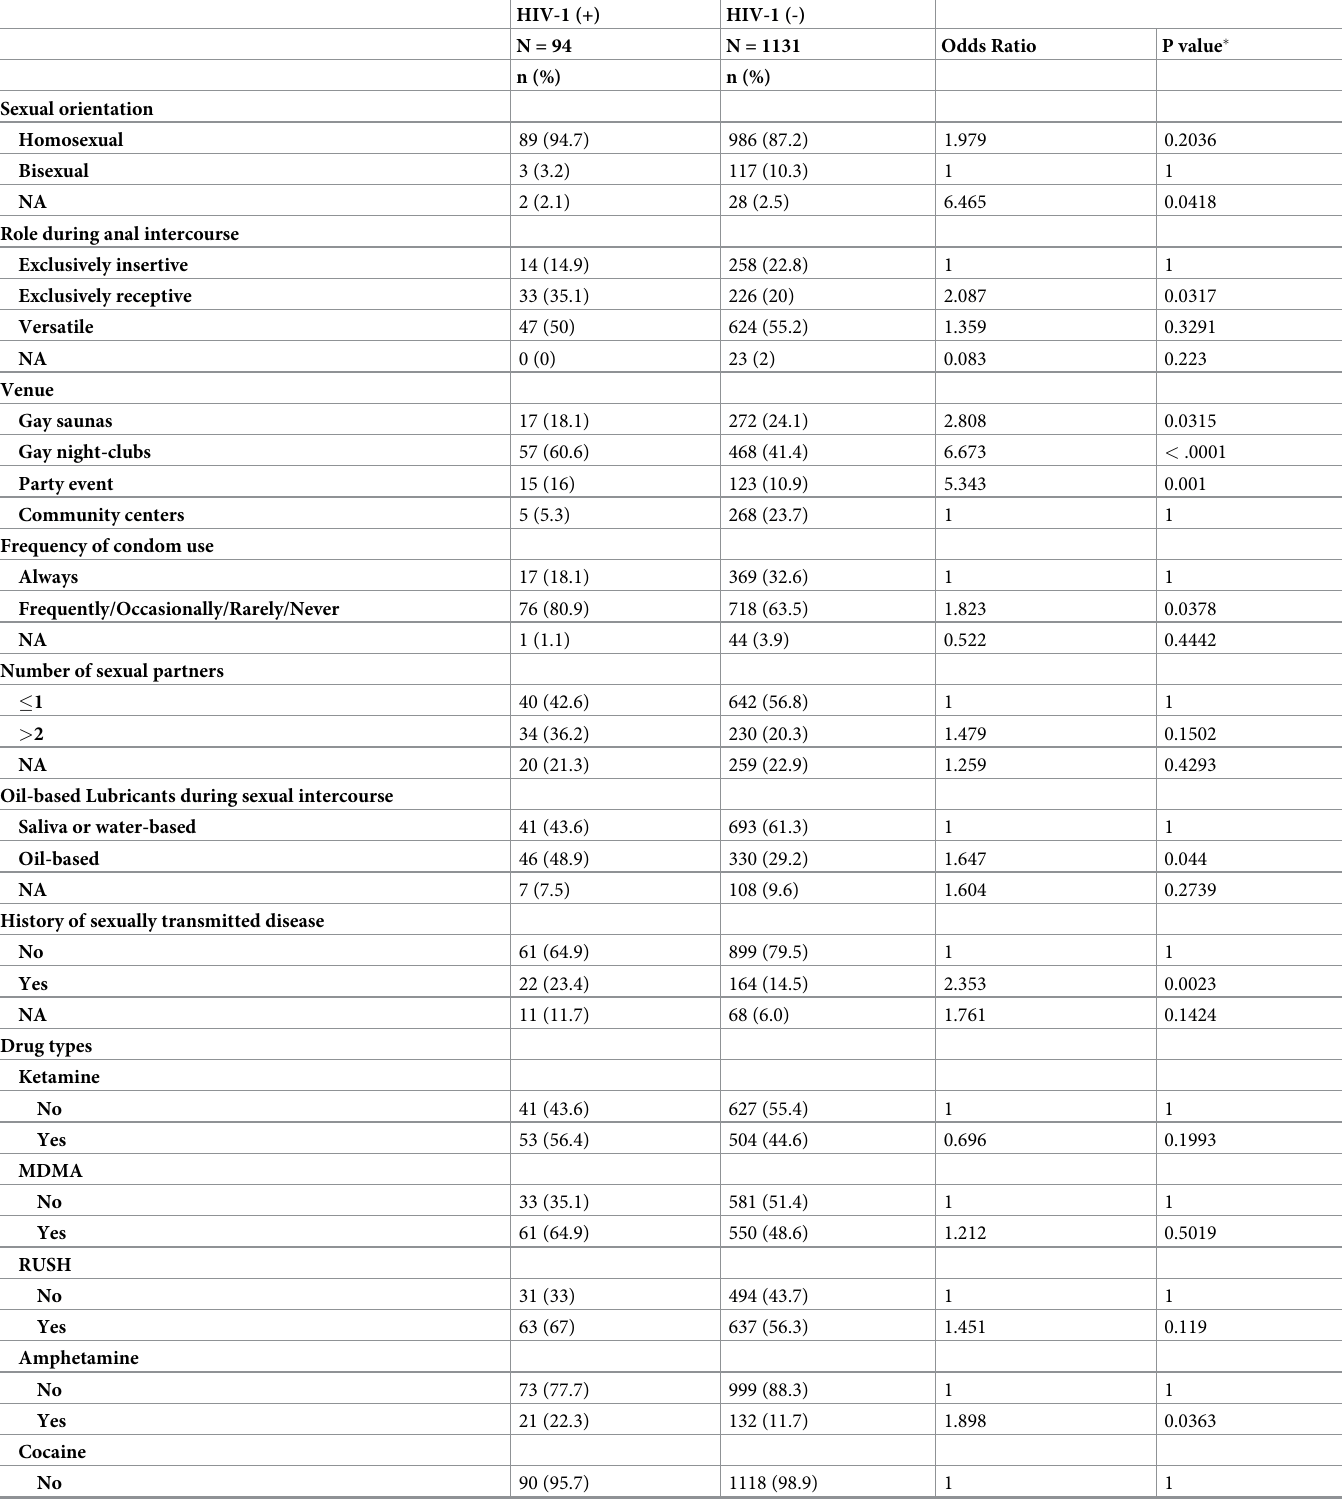
Table 6. Multivariate logistic regression of risk factors for HIV-1 infection among MSM who reported recreational drug usage in